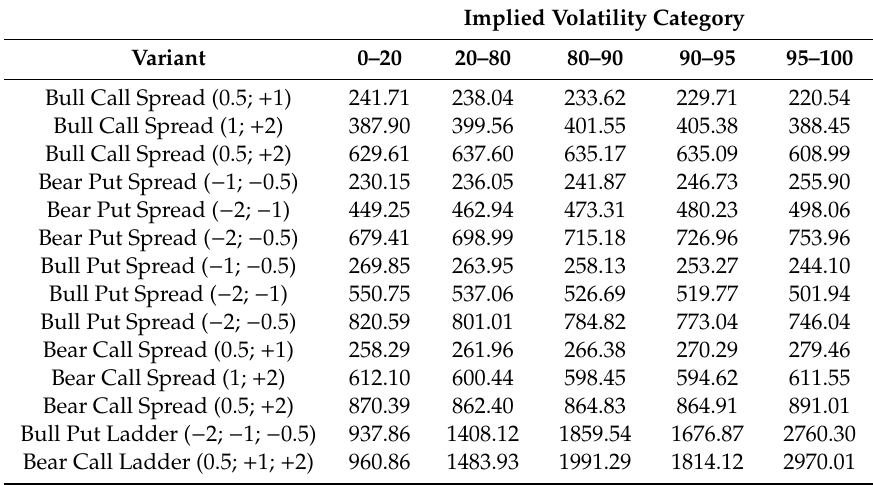
Table A1. Average cost (maximum loss) of vertical spreads for each category of implied volatility (in USD).